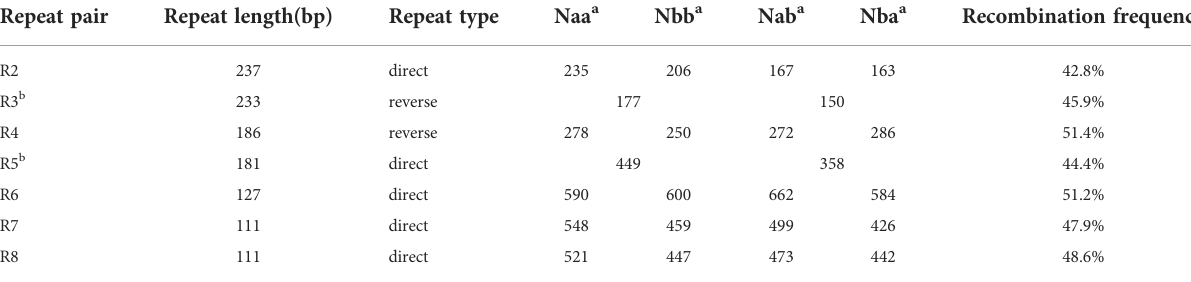
TABLE 1 Repeat-mediatied recombination in the Aeginetia indica mitogenome. Repeat